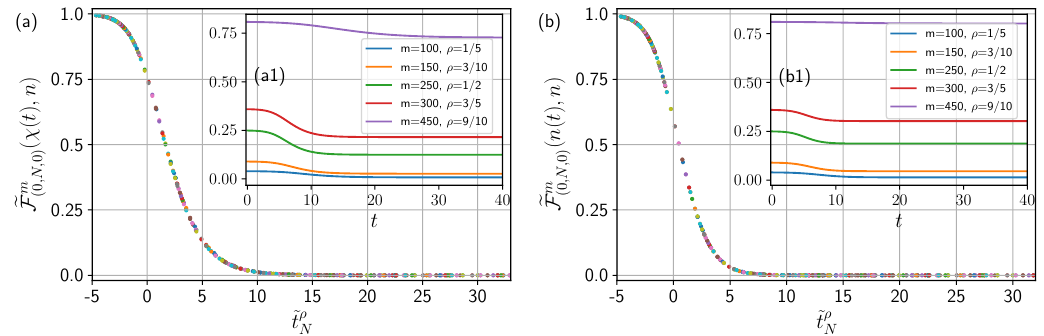
( χ ( t ) , n ) in (a) and e F m ( n ( t ) , n ) (0 ,N, 0) (0 ,N, 0) . We choose m = N ( χ ( t ) , n ) and F m ( n ( t ) , n ) (0 ,N, 0) (0 ,N, 0)